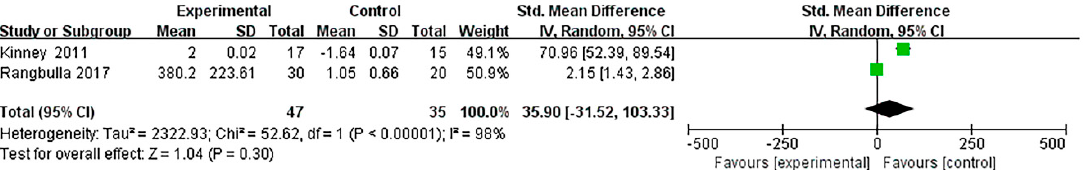
Figure 3. Effects on salivary MMP-8 after non-periodontal surgery therapy. Note: green color, random effect interval in each study; black, total effect.